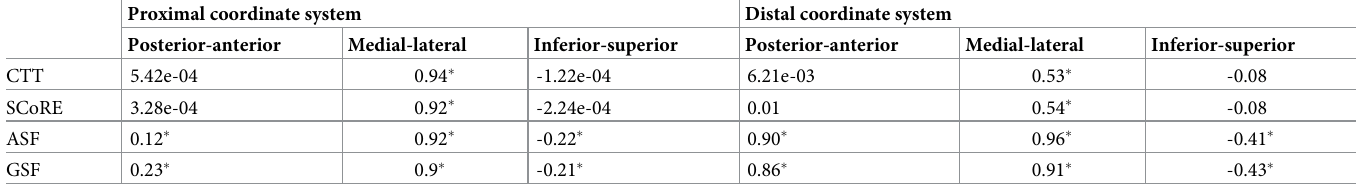
Table 2. Correlation coefficients of distance of proximal and distal coordinate origin from the joint centre against CoR errors. Proximal coordinate system Distal coordinate system Posterior-anterior Medial-lateral Inferior-superior